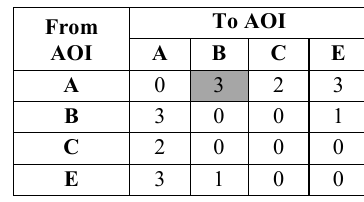
Table 2. AOI transition matrix developed from the AOI fixation sequence for time interval 1 within Table